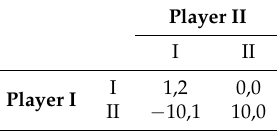
Table 4. An example where the follower does not benefit from incentive equilibrium.